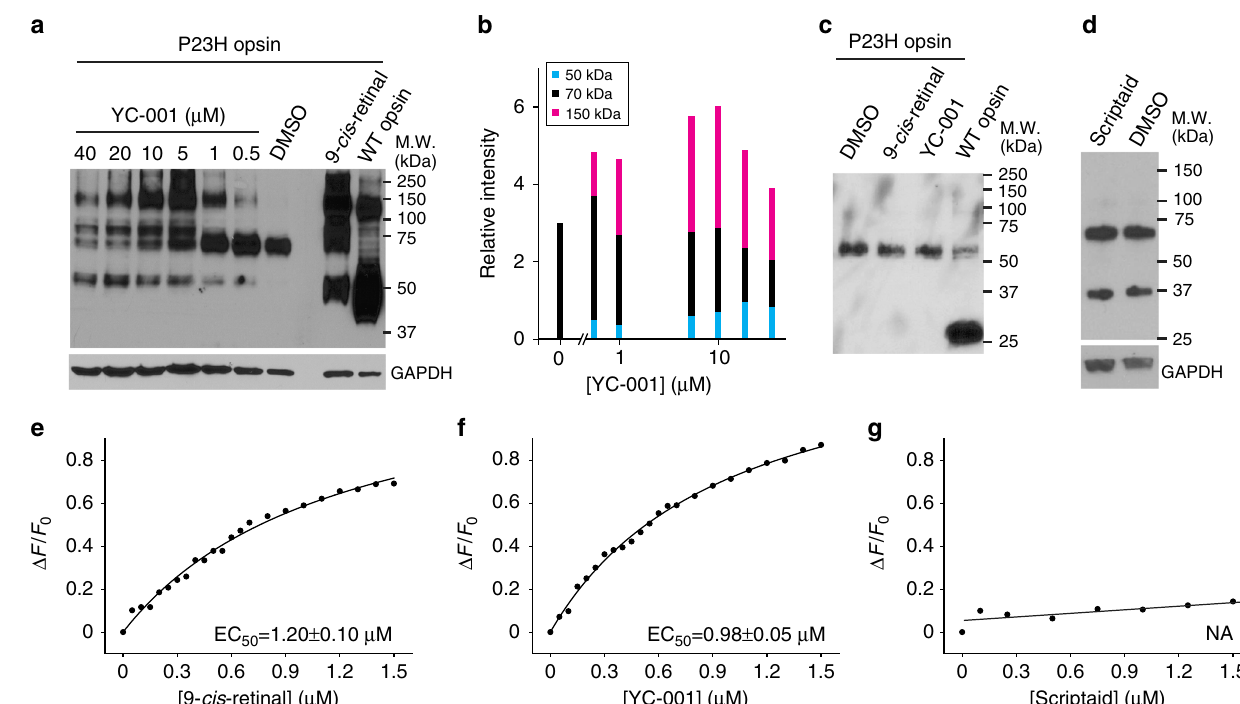
Fig. 3 YC-001 improved the glycosylation pro fi le of P23H opsin. a Effect of different treatments on immunoblots of lysates from NIH3T3 cells expressing WT or P23H opsin. Top panel, immunoblot of opsin; bottom panel, immunoblot of GAPDH. Lanes from left to right, immunoblots from a total of 15 µ g lysate from NIH3T3 cells expressing P23H opsin that were treated with 40, 20, 10, 5, 1, or 0.5 µ M YC-001, 0.1% DMSO, or 5 µ M 9- cis -retinal, respectively; WT-opsin, immunoblot from a total of 5 µ g lysate from NIH3T3 cells expressing WT-opsin treated with 0.1 % DMSO. b Relative intensities of P23H-opsin bands at 50 kDa (blue bars), 70 kDa (black bars) and 120 kDa (magenta bars) represented in cumulative bars as a function of YC-001 dosage. The band at 50 kDa is an opsin monomer with mature glycosylation; the band at 70 kDa is an opsin dimer with immature glycosylation; the band at 120 kDa is an opsin dimer with mature glycosylation. c Immunoblot of opsin from cell lysates deglycosylated by PNGaseF. Lanes from left to right, lysates from NIH3T3 cells expressing P23H opsin treated with either 0.1% DMSO, 5 µ M 9- cis -retinal or 10 µ M YC-001, respectively; WT-opsin, lysate from NIH3T3 cells expressing WT-opsin treated with 0.1% DMSO. d Immunoblot of P23H opsin from cells treated with 10 µ M scriptaid or 0.1% DMSO, respectively. Immunoblot of GAPDH is shown on the bottom as a loading control. e – g Ligand-binding affects the chromophore-binding pocket of rod opsin. Bovine opsin within the ROS disc membranes was used for this assay. Trp fl uorescence of opsin was measured both before and after addition of ligands (Supplementary Fig. 2). Changes of fl uorescence intensity at 330 nm ( Δ F/F0 ) are plotted as a function of the concentration of 9- cis -retinal ( e ), YC-001 ( f ), or scriptaid ( g ), respectively. Binding curves were fi tted with the Hill function using Origin software. EC 50 s ( μ M) of each ligand were calculated and averaged from three biological repeats ± s.d.s and are indicated in the respective graphs. This experiment was repeated